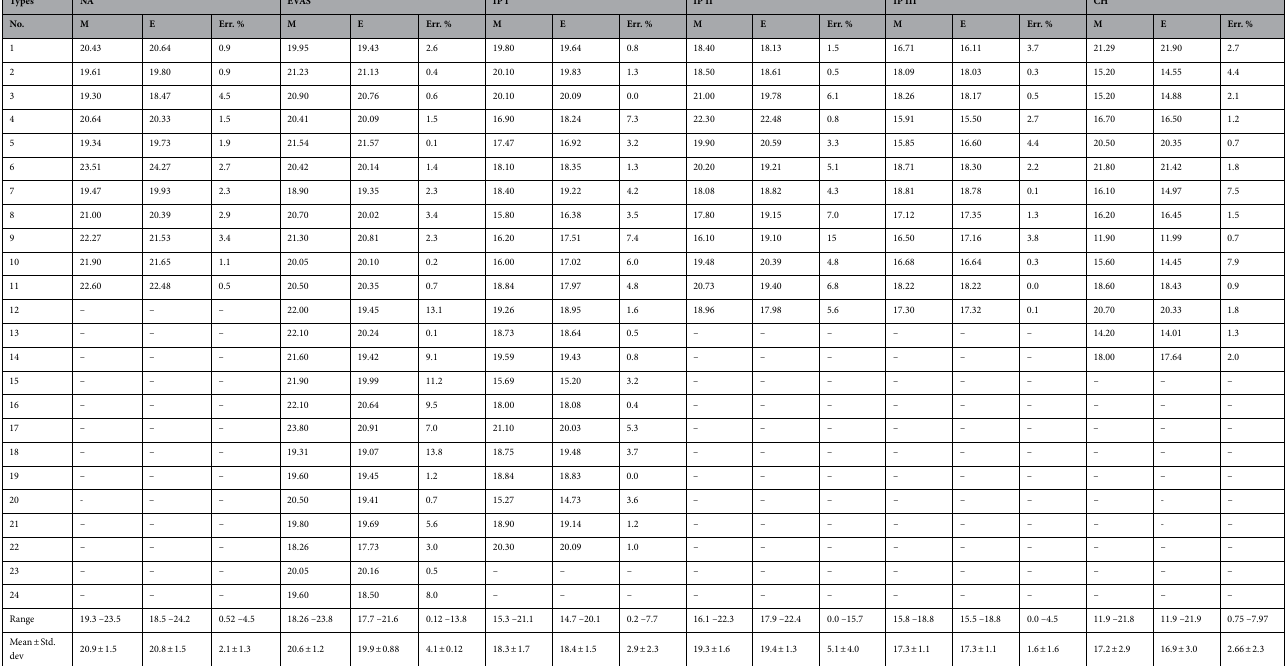
Table 2. Basal turn length (BTL) (mm) as measured and estimated, along with the relative error between the two values in percentage. NA normal anatomy, EVAS enlarged vestibular aqueduct syndrome, IP